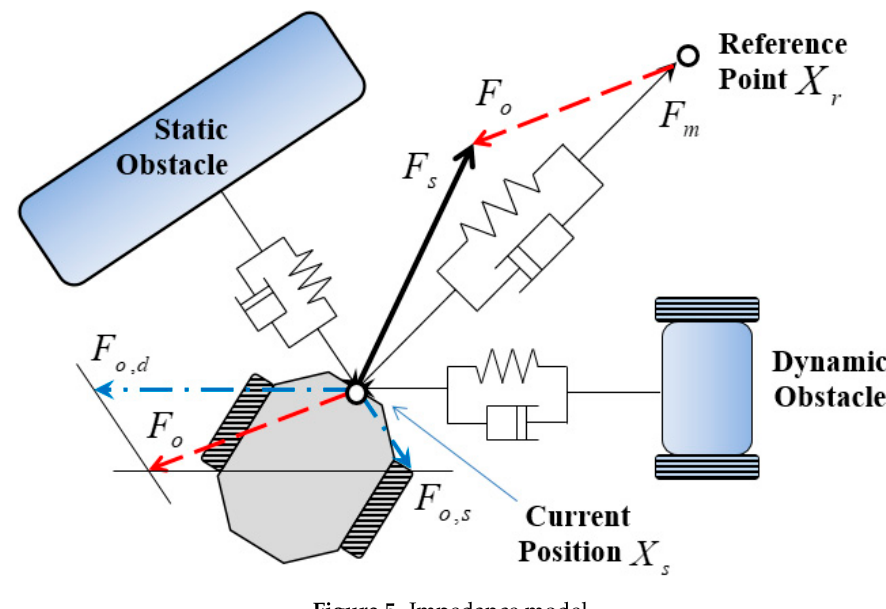
Figure 5. Impedance model.